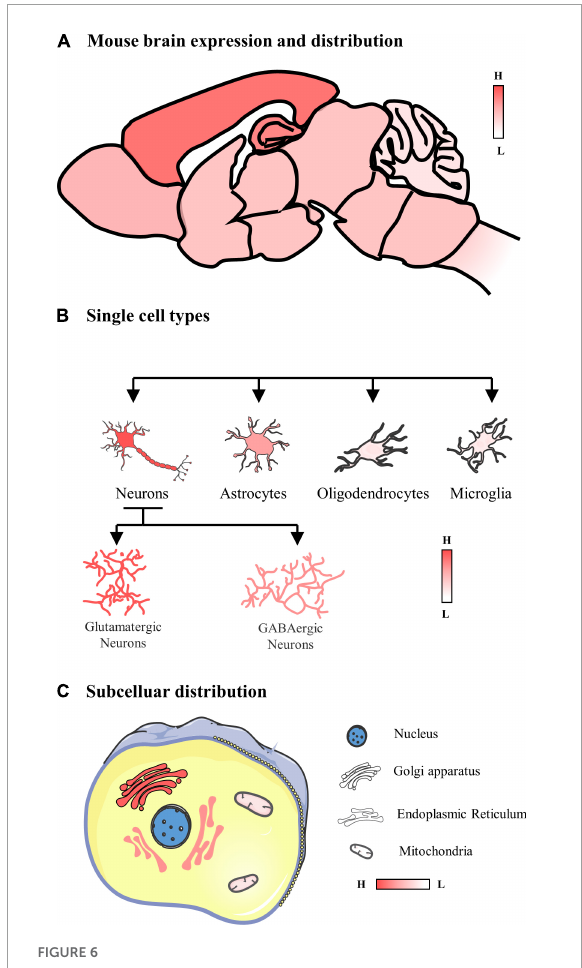
FIGURE6 Schematic of the expression and distribution of POMGNT1 in the adult normal mouse brain. (A) The expression and distribution of POMGNT1 in the central nervous system of the adult mouse. POMGNT1 is widely distributed throughout the adult mice brain with regional specificity. Overall, POMGNT1 is enriched in the cerebral cortex and hippocampus. (B) The neuronal glial cell subtype specific distribution of POMGNT1. POMGNT1 was distributed in both neurons and neuroglia but they differed in the percentage of POMGNT1 positivity. The highest percentage of POMGNT1 positivity was found in mature neurons, higher in astrocytes, and least in oligodendrocytes and microglia. In contrast, the percentage of POMGN1 positivity was higher in glutamatergic neurons than in GABAergic neurons. (C) Subcellular specific localization of POMGNT1. POMGNT1 is expressed in the cytoplasm, mainly in the Golgi apparatus, followed by the endoplasmic reticulum, with the least in the